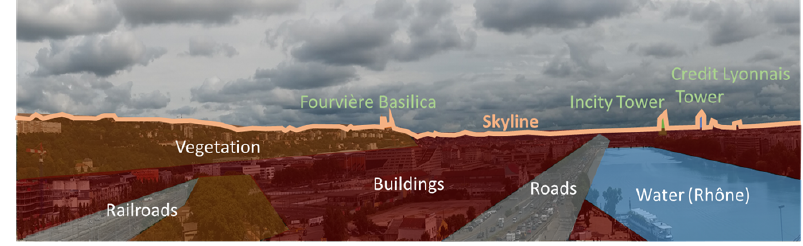
Figure 1. View composition regarding city